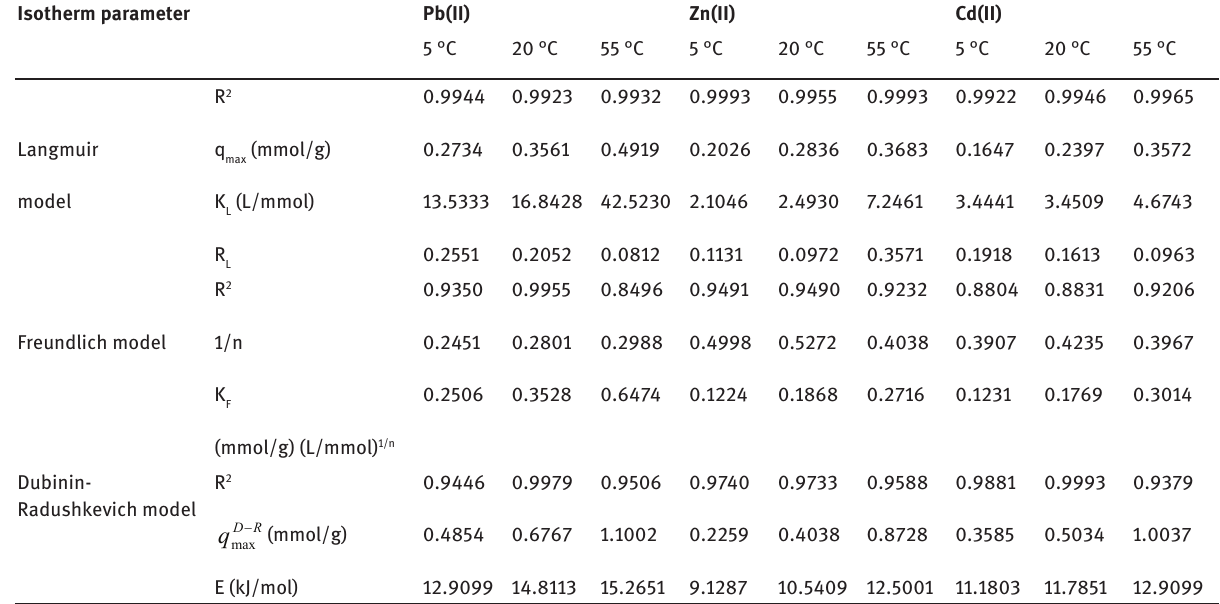
Table 5: Isotherm parameters for the biosorption of Pb(II), Zn(II) and Cd(II) onto mustard waste biomass. Isotherm